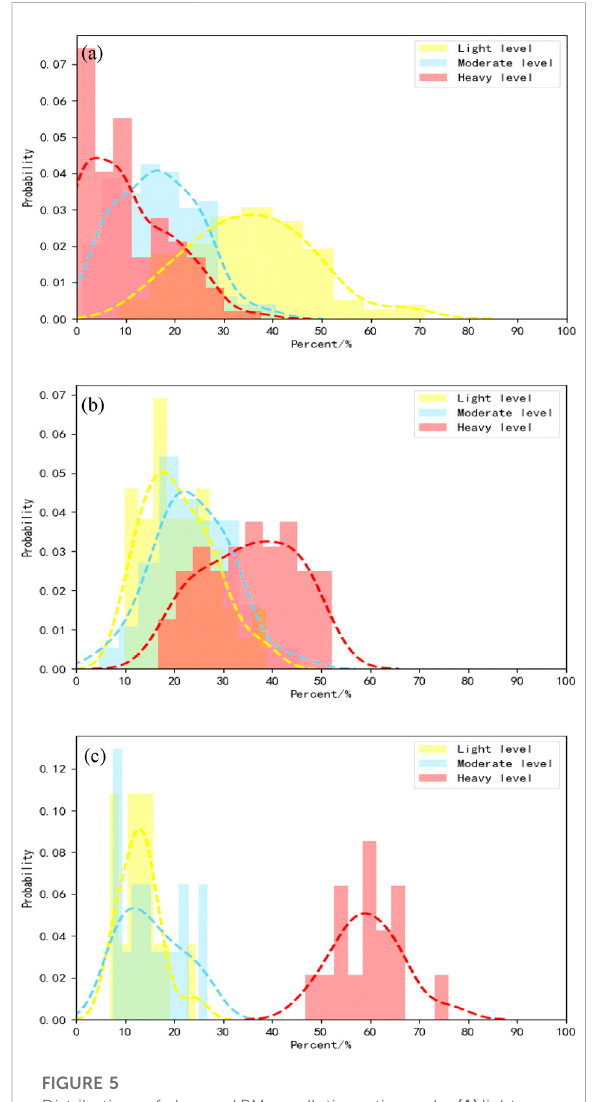
FIGURE 5 DistributionsofobservedPM 2.5 pollutionratiosunder (A) light pollution, (B) moderate pollution and (C) heavy pollution in BTH and its surrounding areas.